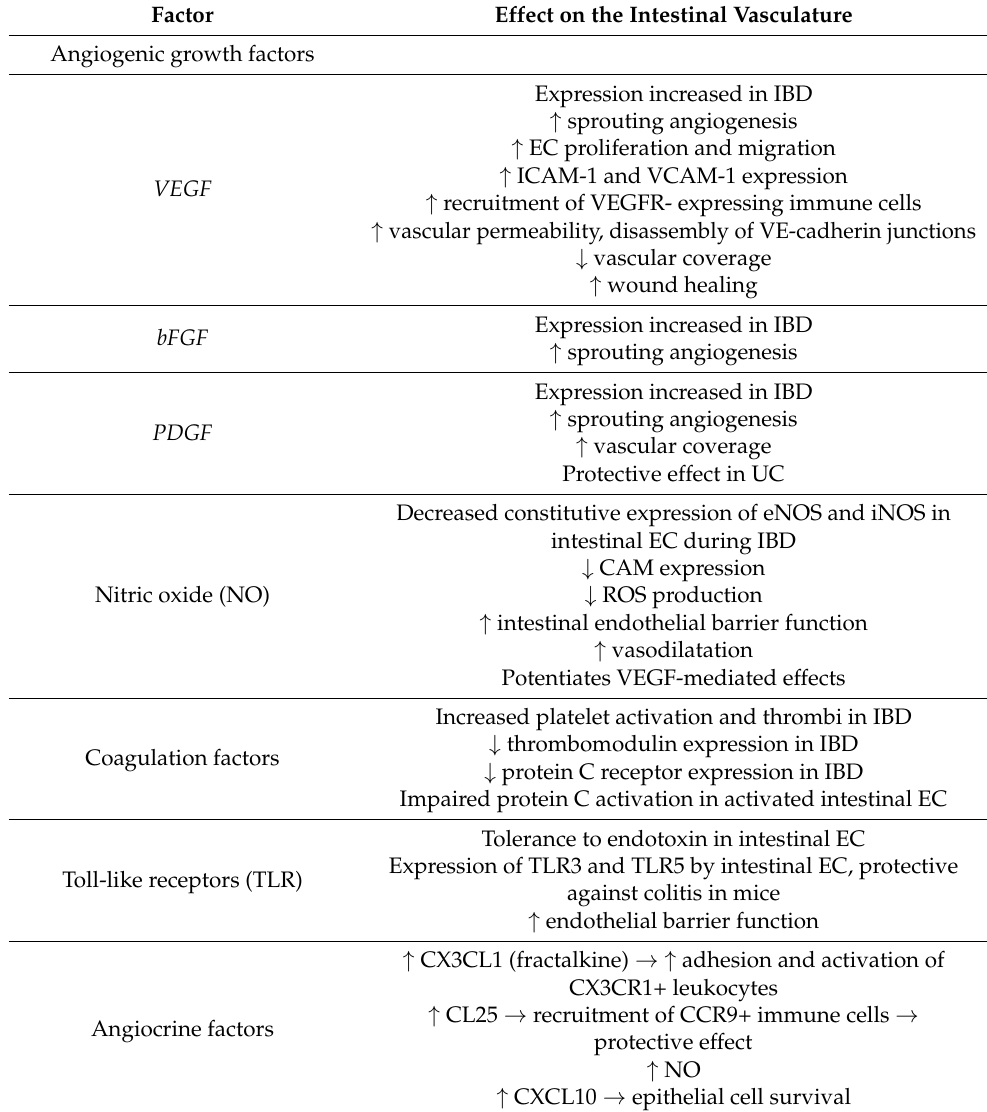
Table 3. Pathogenic effects of vascular factors in